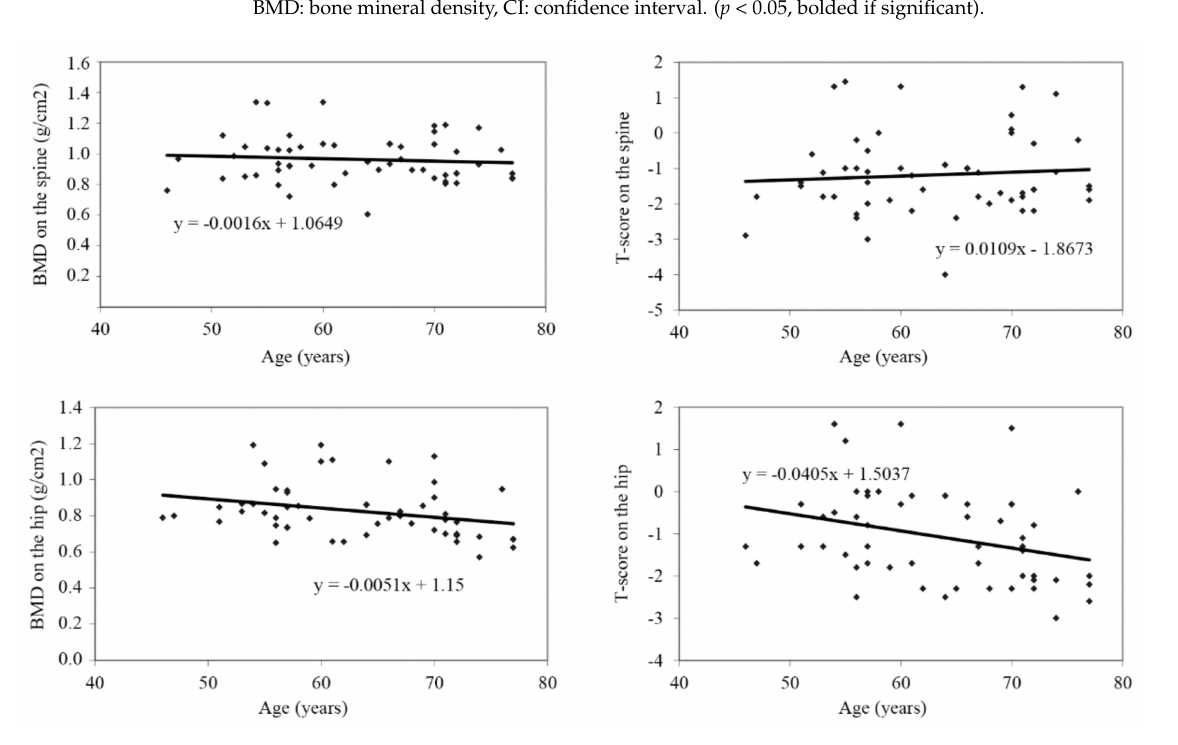
Figure 2. Correlation between age and BMD (g/cm2) and T-score values of the spine and